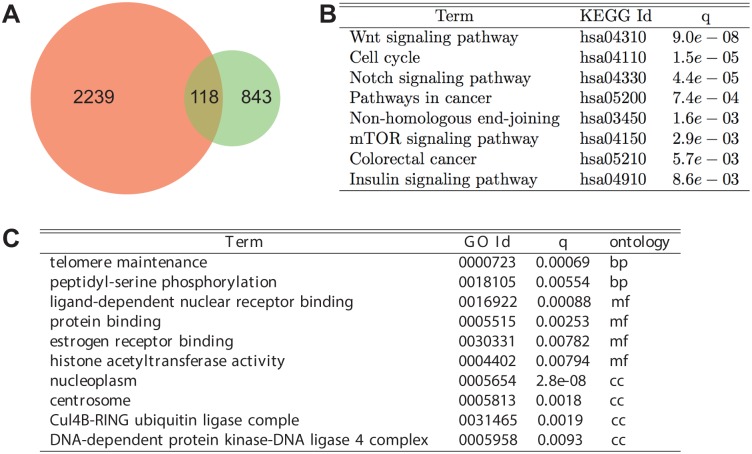
Functional analysis of the consensus predicted ECCN target gene set.Overlap between 2357 new ECCN elements (orange) based on expression pattern correlation and 961 genes obtained with text-mining methods (green) (A). This resulted in 118 new genes found by both methods. KEGG pathway annotation enrichment of the 118 consensus predicted genes (B) and corresponding GO enrichment (C).